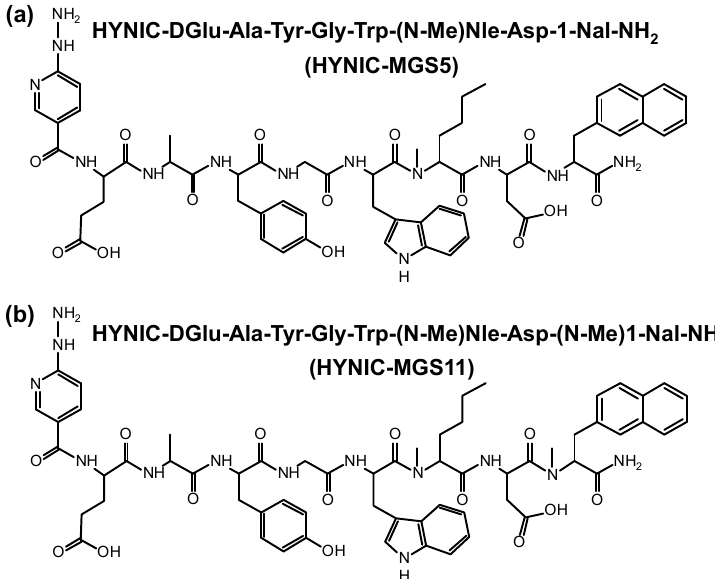
Figure 1. Amino acid sequence and chemical structure of ( a ) HYNIC ‐ MGS5 and ( b ) HYNIC ‐ MGS11. Radiolabeling with technetium ‐ 99m using the exchange labeling approach from tricine, used as intermediate coligand, to EDDA yielded in [ 99m Tc]Tc ‐ HYNIC ‐ MGS5 [ 99m Tc]Tc ‐ HYNIC ‐ MGS11 at high molar activity of 35–40 GBq/ μ mol comparable to previously